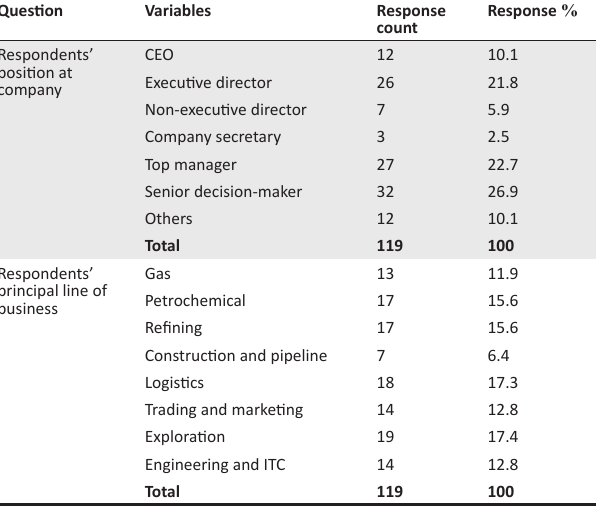
TABLE 2: Profile of the respondents. Question